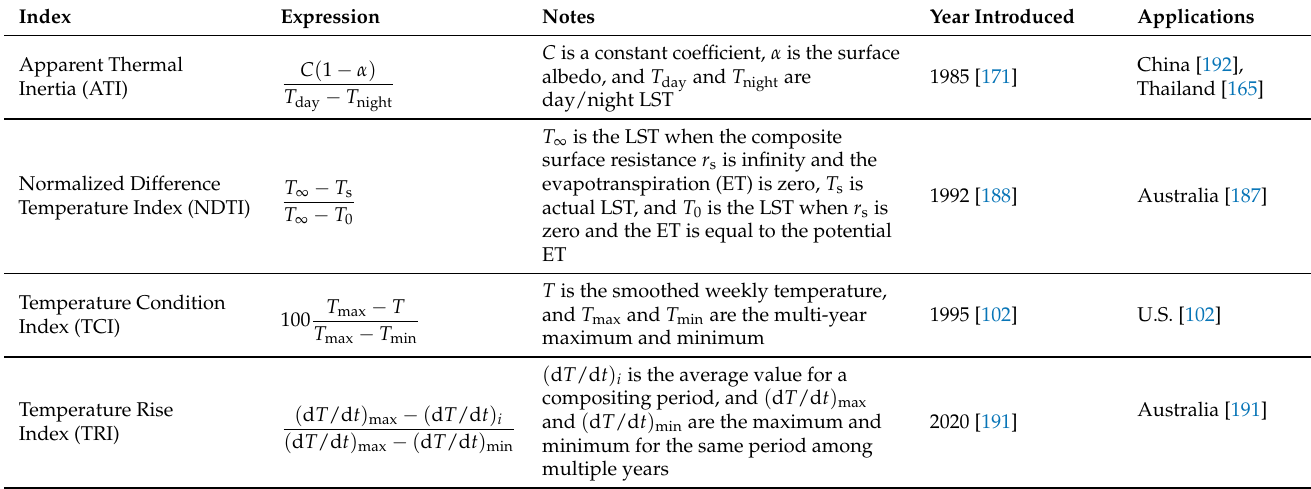
Table 3. Summary of thermal indices suitable for agricultural drought